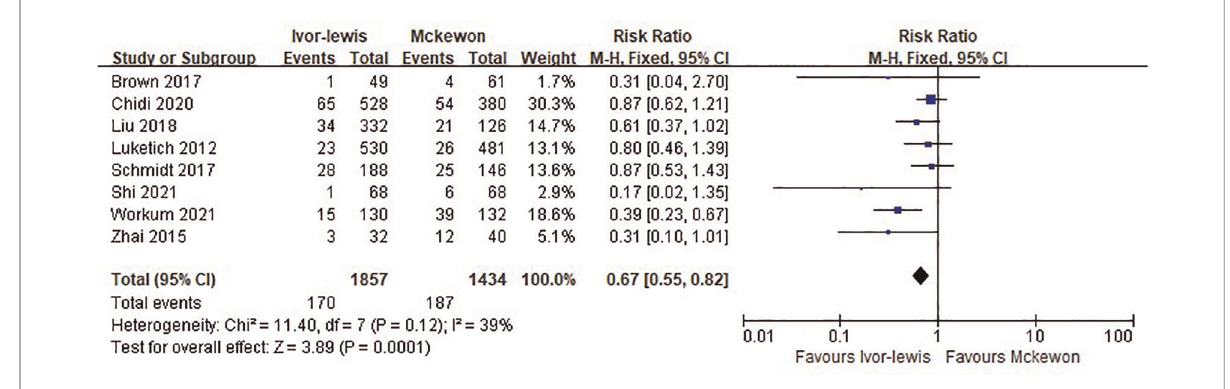
FIGURE 2 Forest plots of the all grades anastomotic leak analysis in Ivor Lewis procedure vs. McKeown